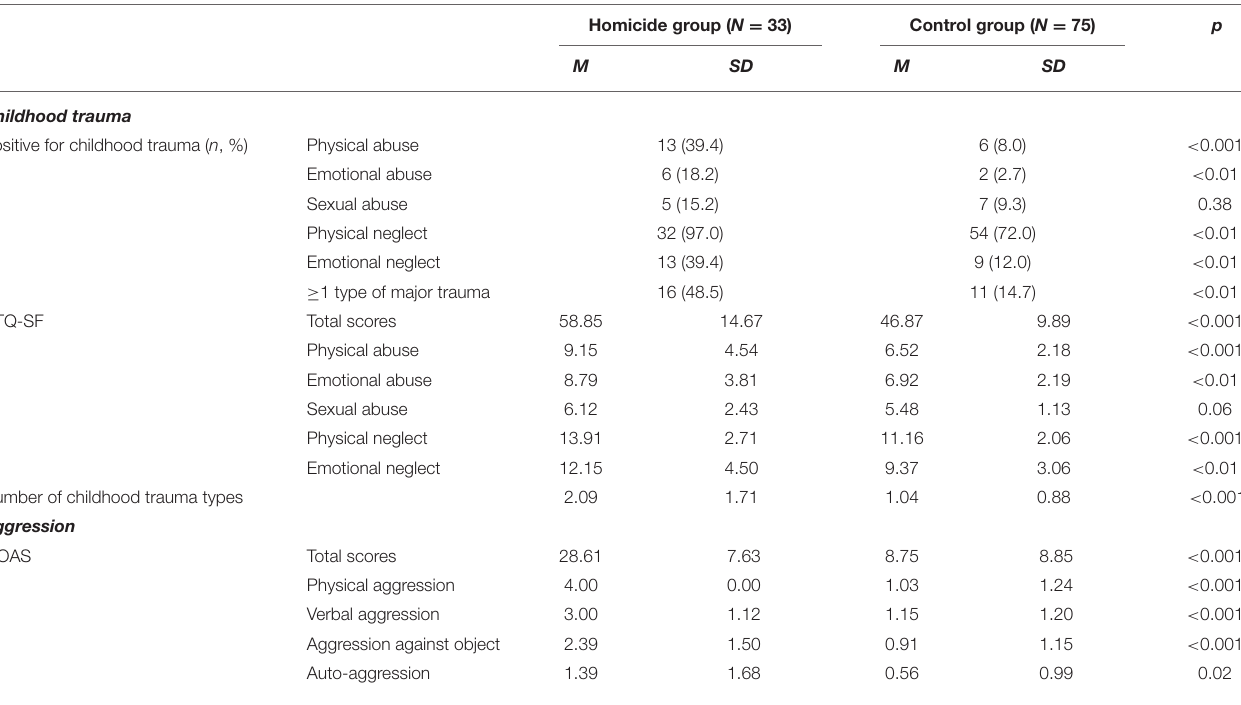
TABLE 2 | Childhood trauma and measures of aggression in all